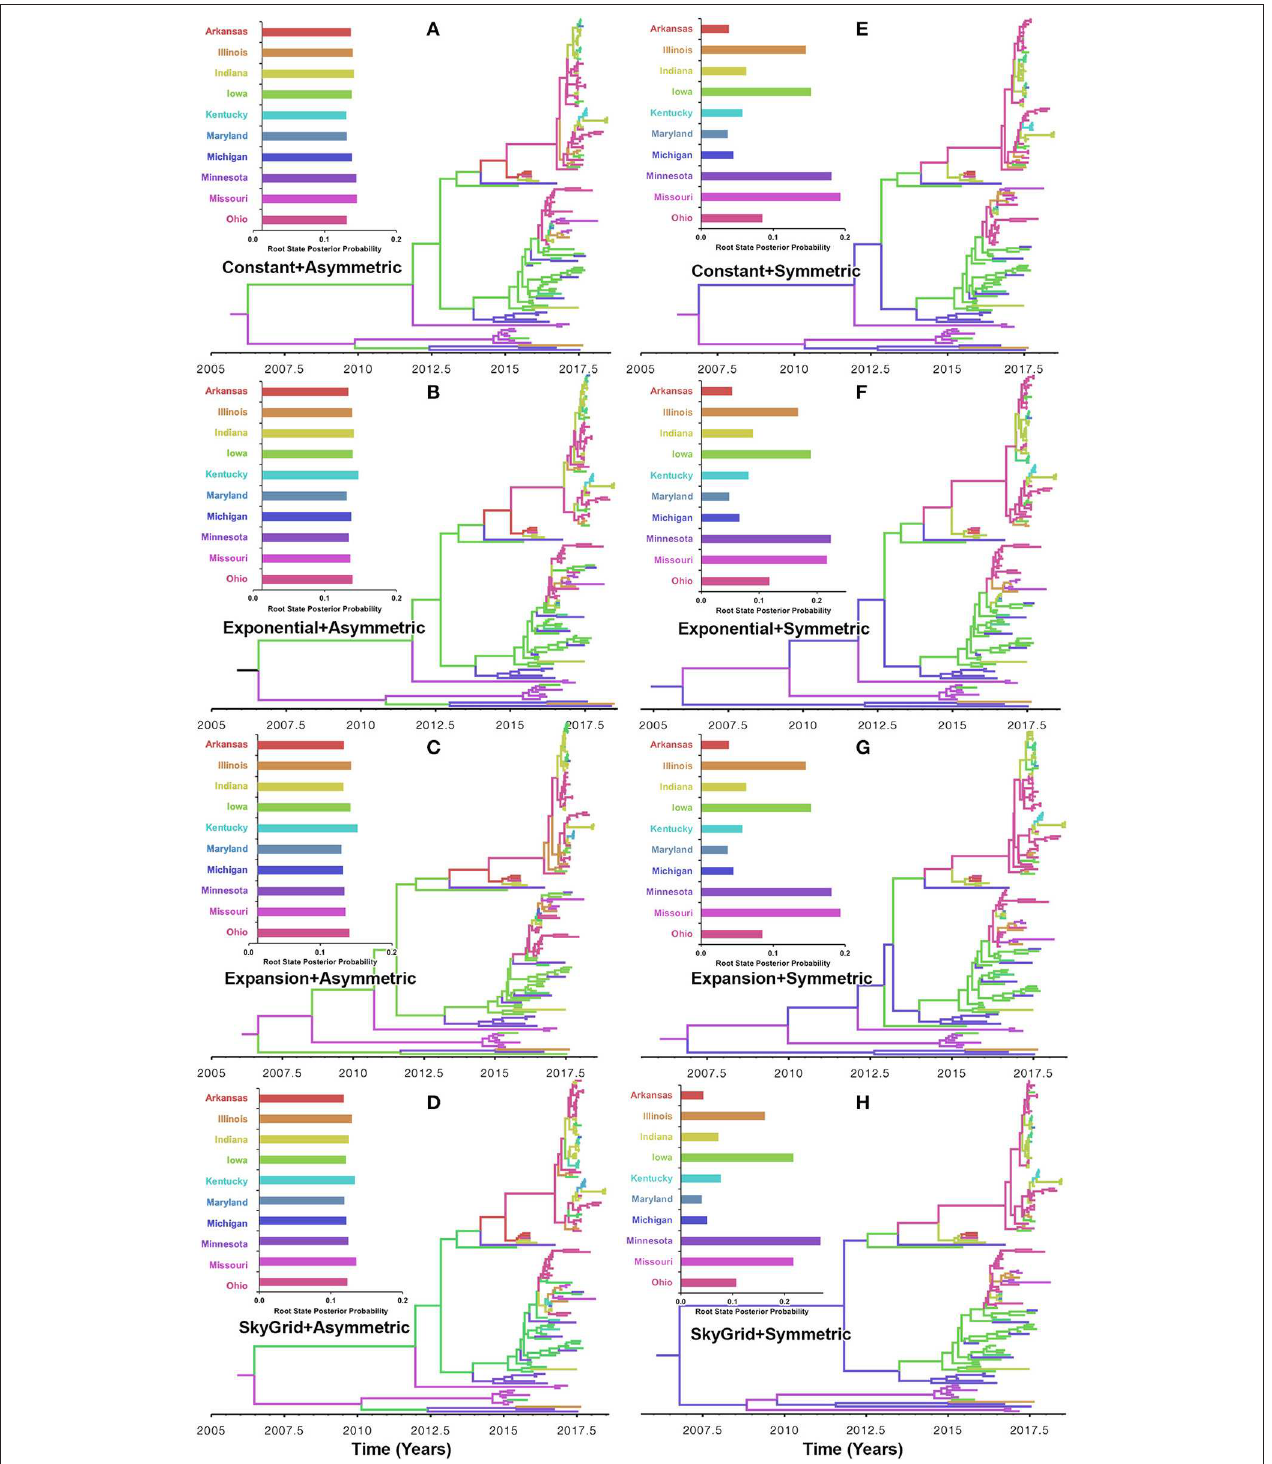
FIGURE 6 | Maximum clade credibility (MCC) phylogeny of the PB2 segment of human-like H3 swine influenza virus collected between January 2015 and June 2018 in the United States. The trees are inferred from eight phylodynamic model combinations (node-age and BSSVS priors). The color of the branches represents the most probable location state of their descendant nodes, and their color-coding corresponds to the upper left bar chart, which represents the root location state posterior probabilities (RSPP) for each state. (A–D) Trees inferred from four node-age + asymmetric BSSVS priors. (E–H) Trees inferred from four node-age + symmetric BSSVS